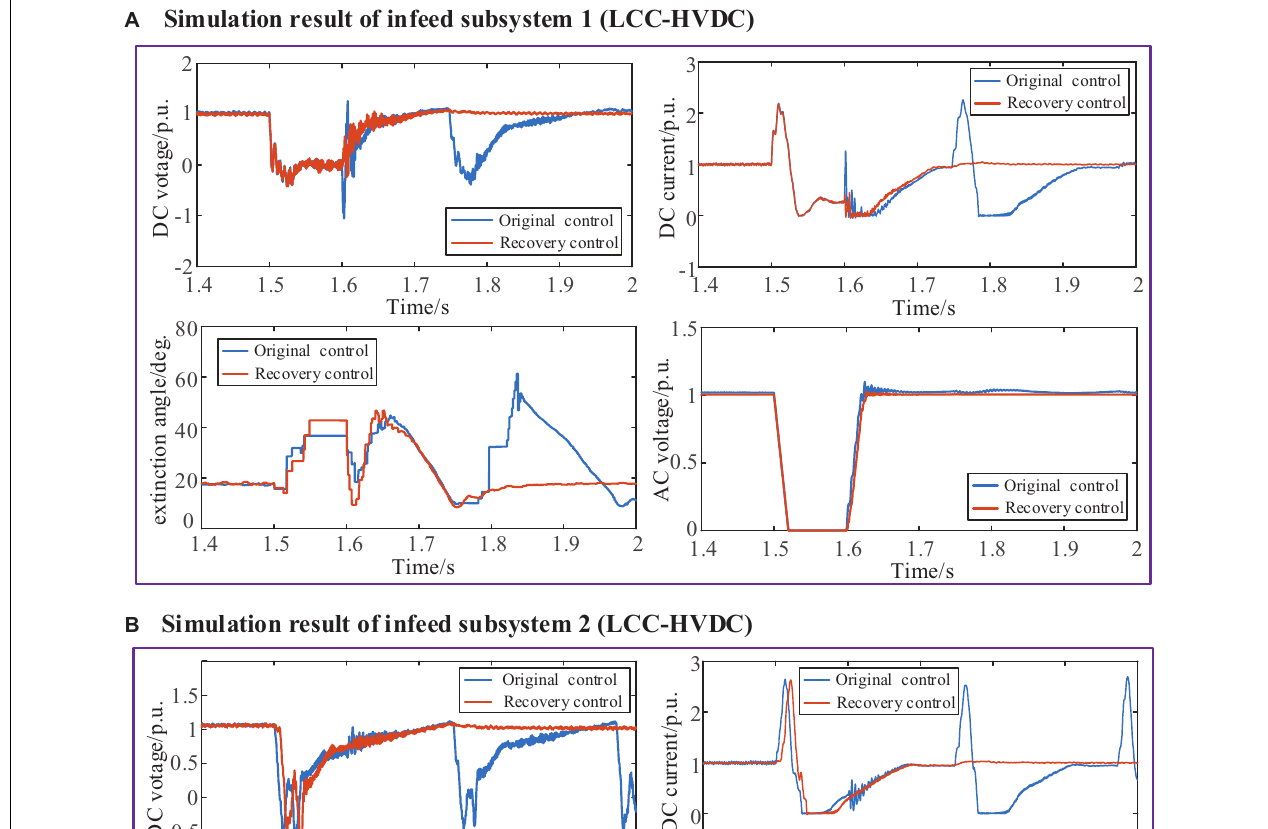
FIGURE 3 | Simulation results of HMIDC after failure. (A) Simulation result of infeed subsystem 1 (LCC-HVDC). (B) Simulation result of infeed subsystem 2 (LCC-HVDC). (C) Simulation result of infeed subsystem 3 (MMC-HVDC).